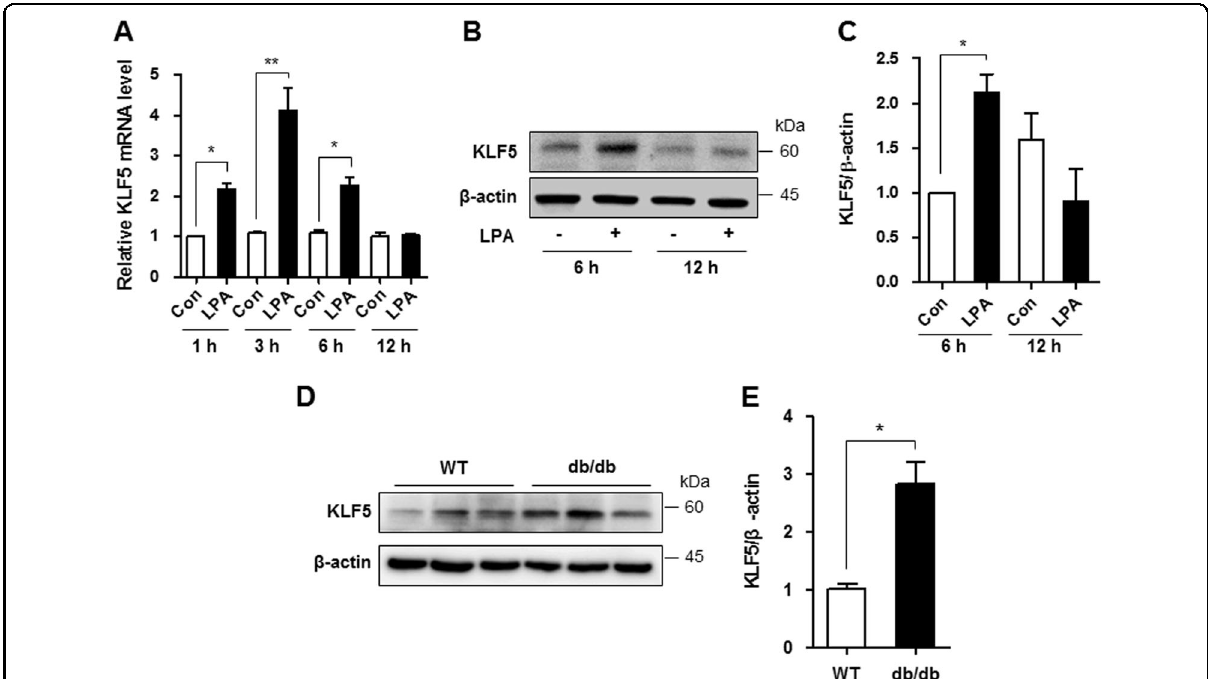
Fig. 3 LPA upregulates KLF5 expression in SV40 MES13 cells. a The expression of the KLF5 mRNA at 1, 3, 6, or 12 h in cells treated with 10 μ M LPA was analyzed using qRT-PCR ( n = 3 independent experiments). b Western blots showing KLF5 and β -actin levels at 6 or 12 h after treatment with 10 μ M LPA. c The relative level of KLF5 was normalized to β -actin and quanti fi ed using ImageJ software. d Western blot showing the level of the KLF5 protein in the renal cortex of 9-week-old wild-type (WT) and db/db mice. e The results were quanti fi ed, and β -actin was used as a loading control ( n = 3 – 4). * p < 0.05, ** p < 0.01. Data are presented as means ±